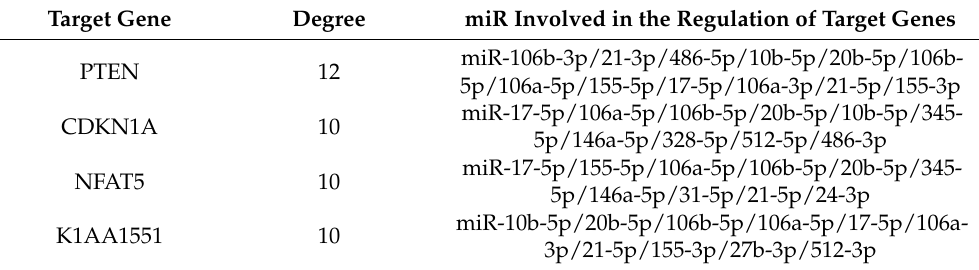
Table 3. Bioinformatic analysis (miRnet) of salivary miRs with diagnostic value for oral inflam- matory diseases showing the top four target genes with the highest degree in the miR-mRNA regulatory